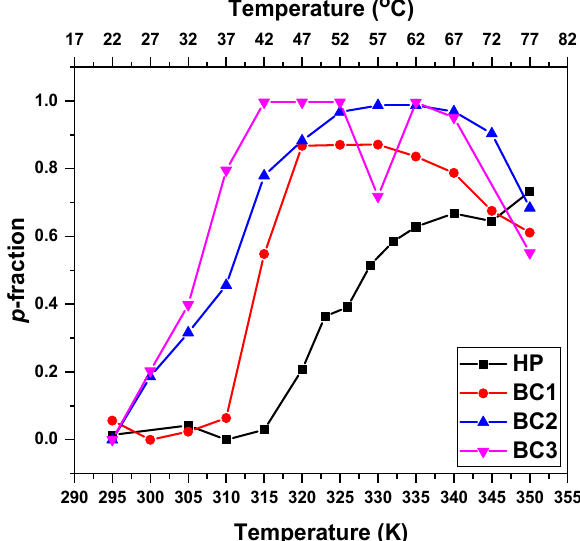
Figure 7. Temperature dependencies of the p -fraction for the PTEGMA CH 2 protons (signal “a”) in D 2 O solutions (c = 2.5 mg · mL − 1 ) of HP and BC1-BC3 copolymers determined during gradual heating.